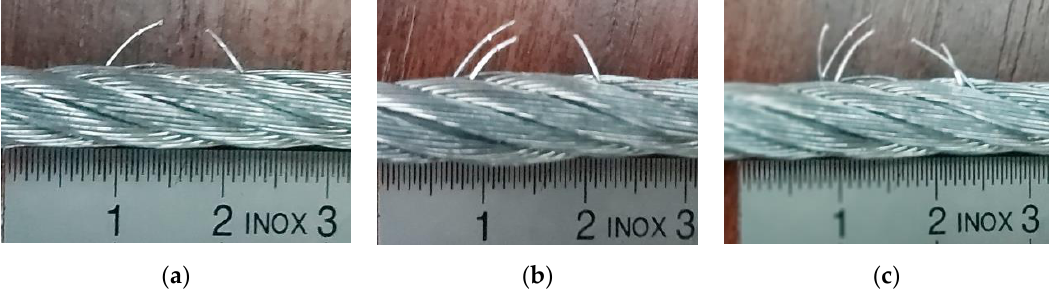
Figure 4. Artificial damages within wire rope structure adopted for presentation: ( a ) damage assigned to second case; ( b ) damage assigned to third case; and ( c ) damage assigned to fourth case. Note that the first case was considered as full integrity (undamaged inspected cable).